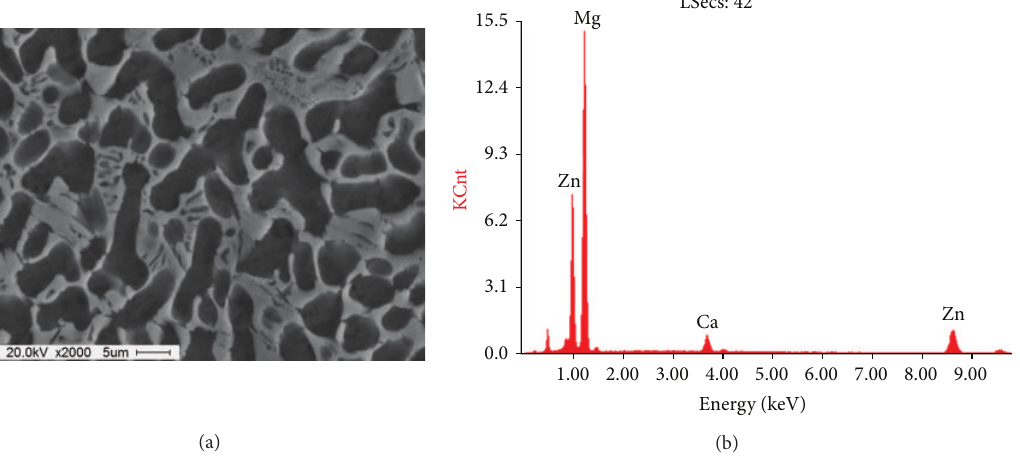
Figure 1: SEM micrograph of as-cast Mg-35Zn-3Ca (a) and EDX spectrum results (b).